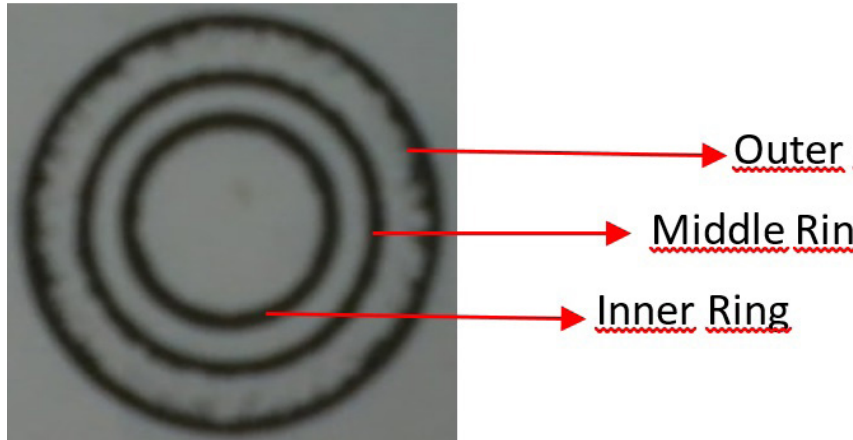
Figure 4. Slide obtained by RPD assay. Source: Author’s own elaboration.